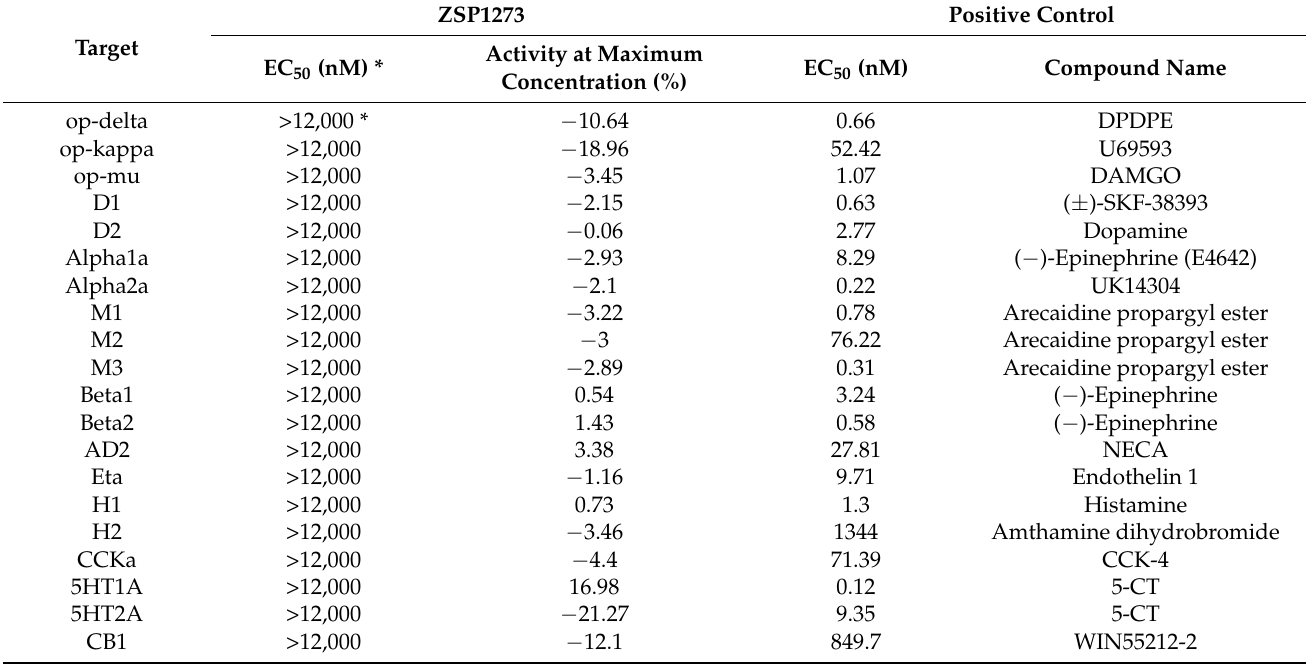
Table A3. Agonistic effects of ZSP1273 against GPCR